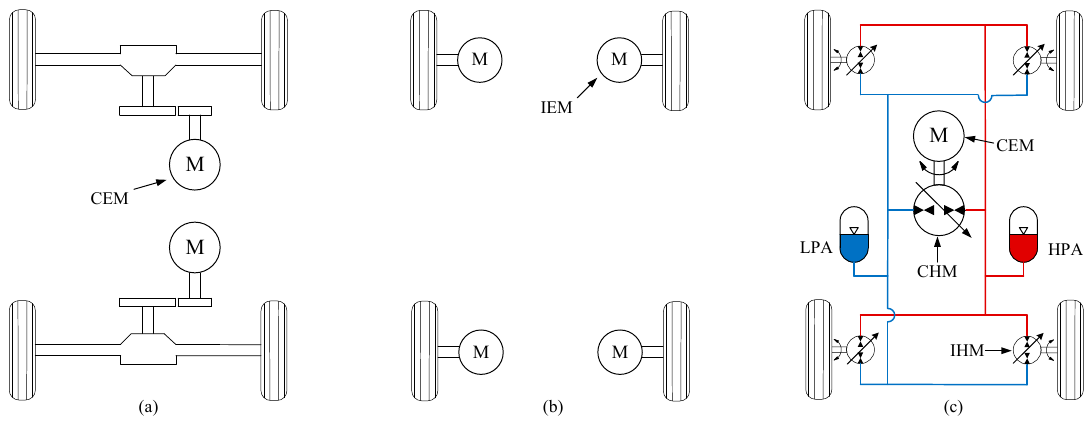
Figure 1 . Powertrain configurations of different vehicles. ( a ) CEV; ( b ) IEV; ( c ) IHV. Figure 1. Powertrain configurations of different vehicles. ( a ) CEV; ( b ) IEV; ( c )